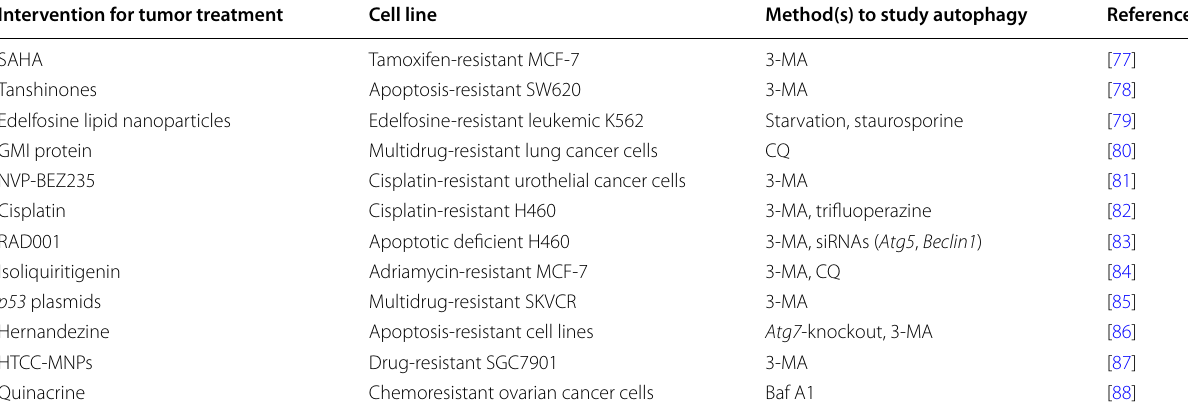
SAHA, suberoylanilide hydroxamic acid; GMI, Ganoderma microsporum immunomodulatory; HTCC-MNPs, N -[(2-hydroxy-3-trimethylammonium)propyl] chitosan chloride/alginate-encapsulated Fe 3 O 4 magnetic nanoparticle; 3-MA, 3-methyladenine; Baf A1, bafilomycin A1; siRNA, small interfering RNA; Atg , autophagy-related gene; CQ,